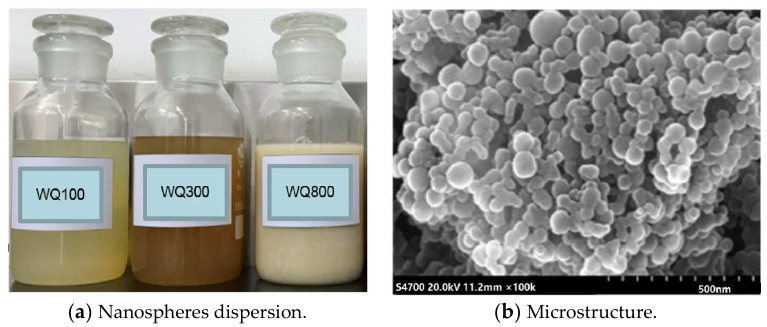
Figure 14. Macro and micro morphology display of nanospheres. Single-phase gel particle (PEG): PEG takes acrylamide, anionic monomer acrylic acid and cross-linked agent as comonomers, and is prefabricated through grinding, granulation and dispersion adopting reverse suspension polymerization. The content of